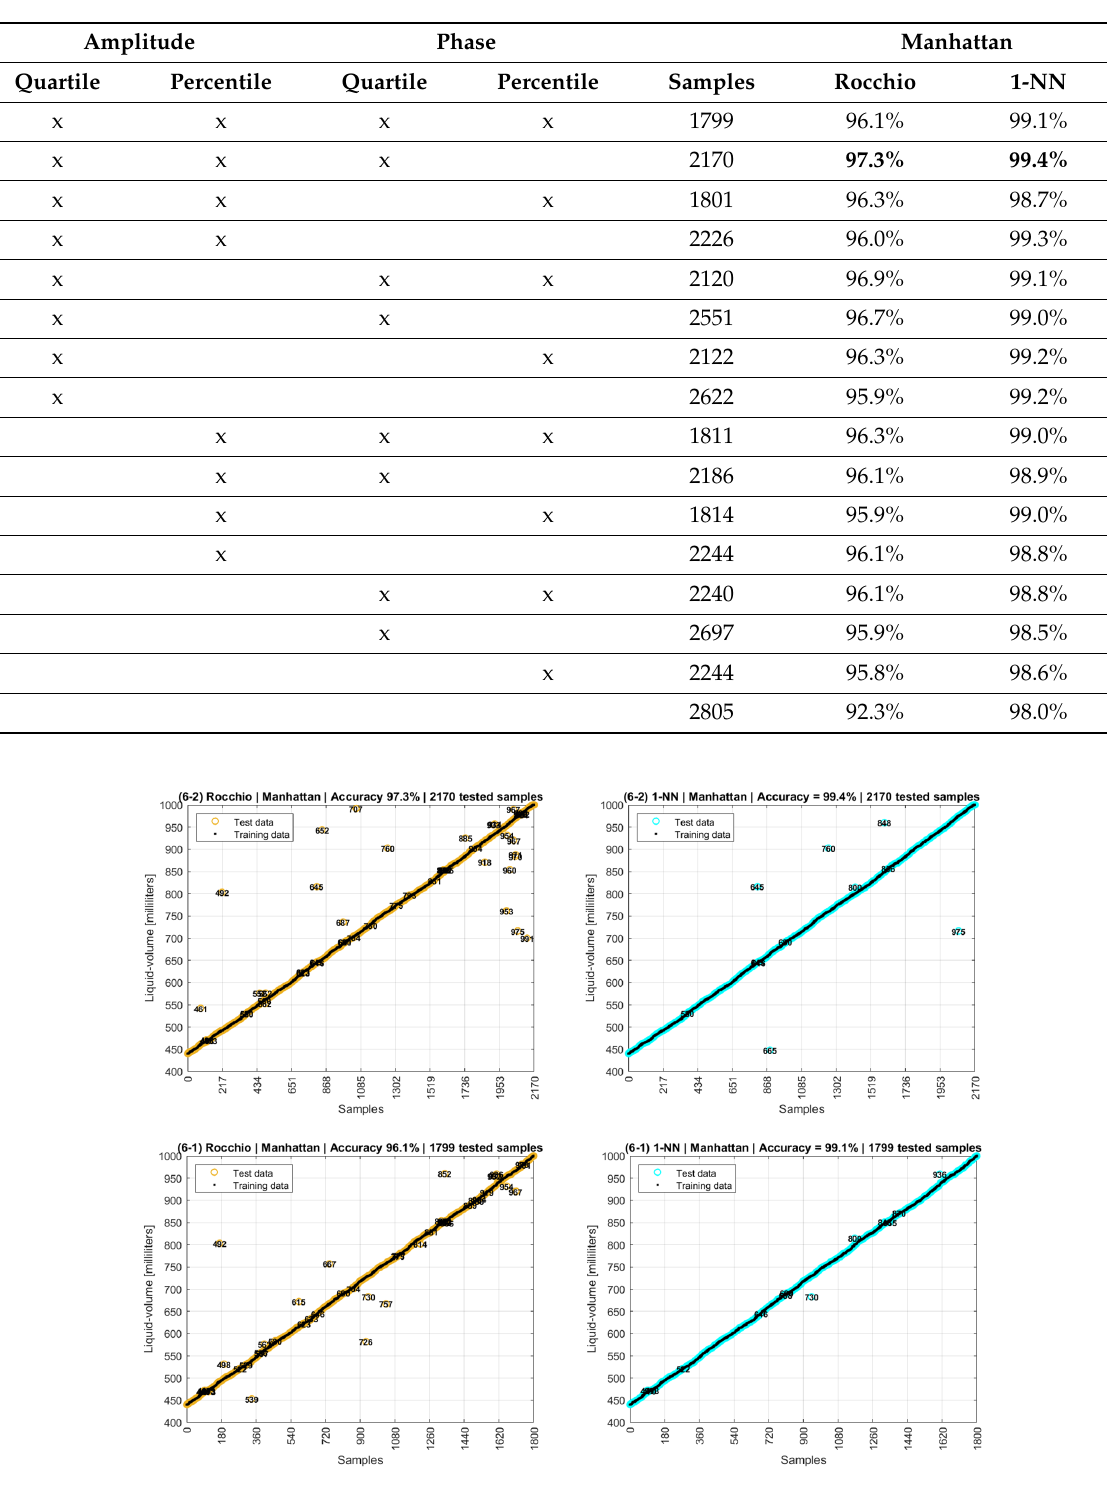
Figure 22. Rocchio and 1-NN accuracies with Manhattan distances over original data collected.